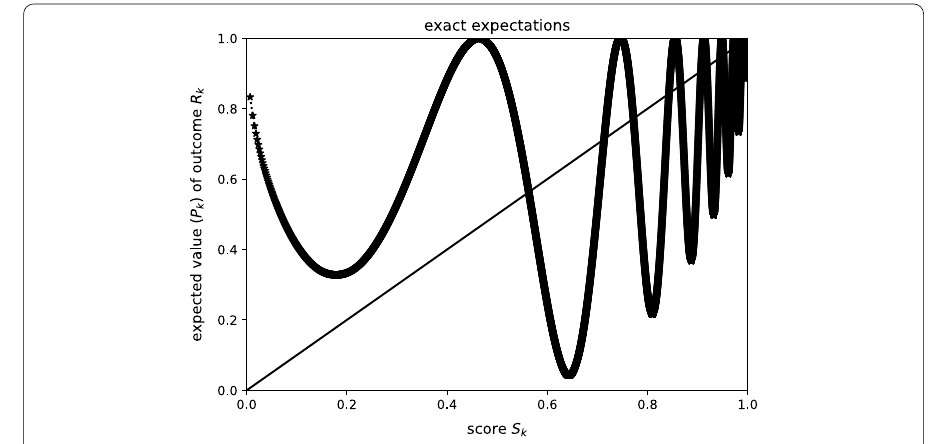
Fig. 41 Ground-truth reliability diagram for Fig.